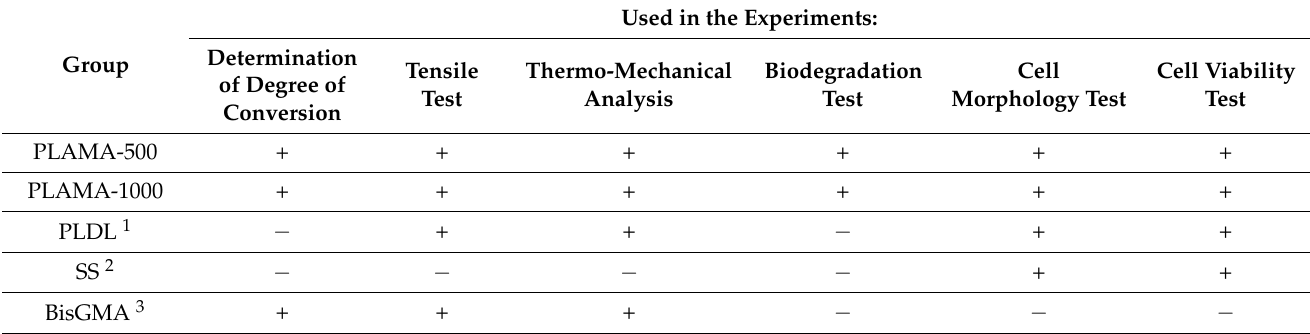
Table 1. Groups of materials used in the